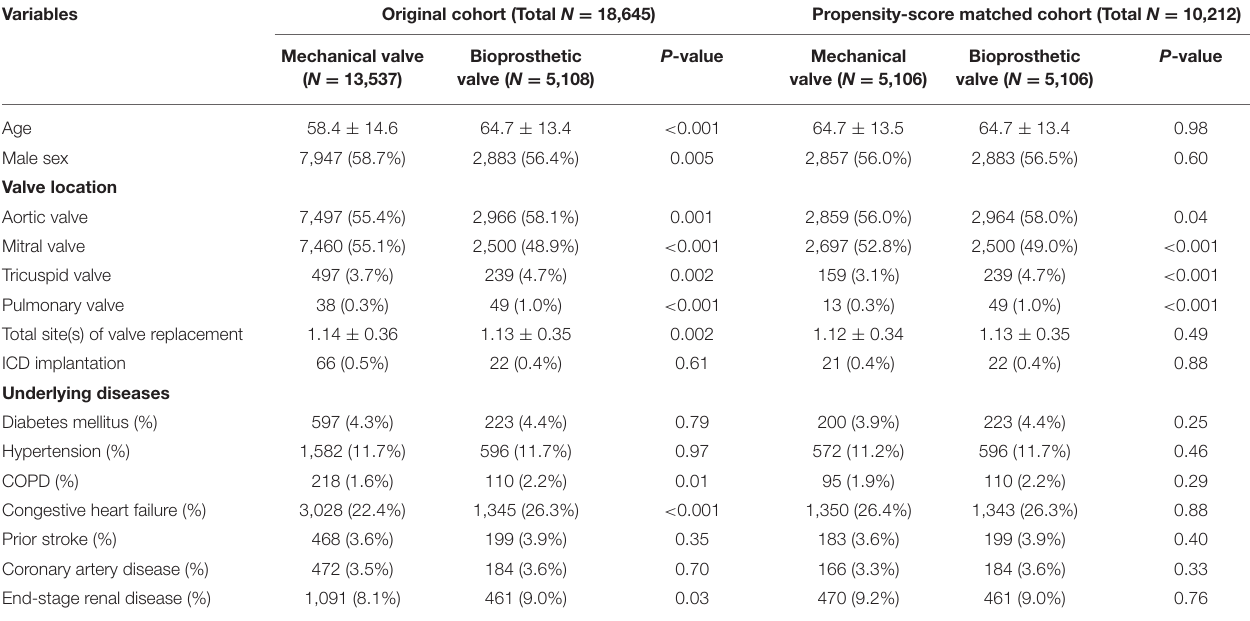
TABLE 1 | Baseline characteristics of the original cohort and propensity-score matched